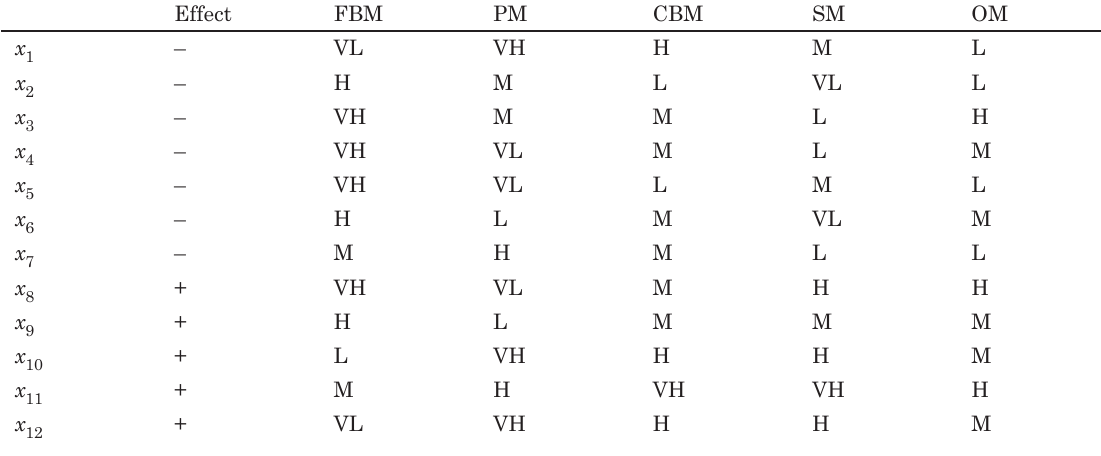
table 4. A sample of decision matrix filled